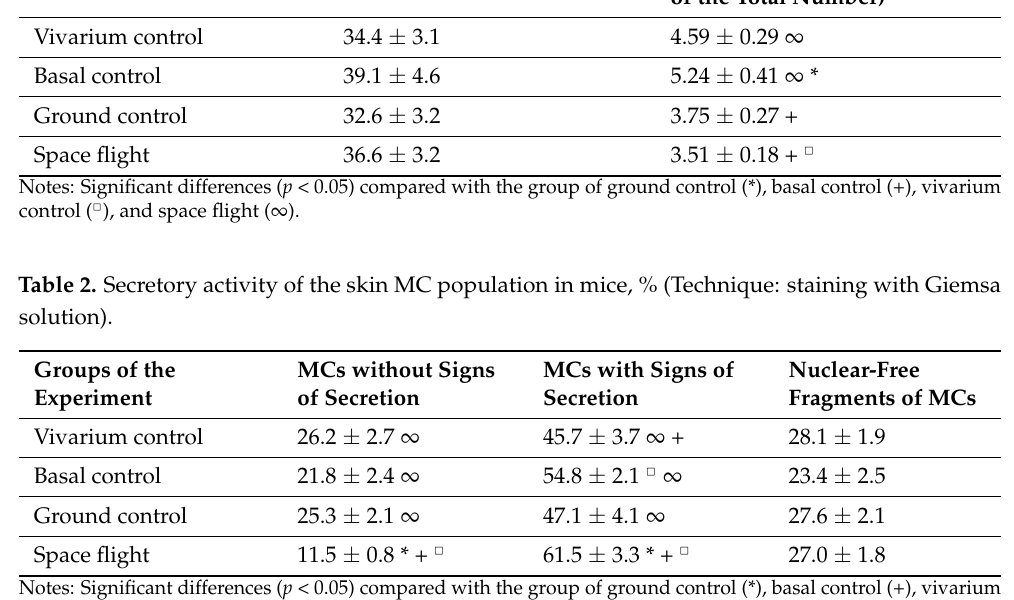
( a ) Fibroblast-associated mast cells form a multicellular fibrillogenic cluster. Active excretion of mast cell secretome into the extracellular matrix. ( b – e ) Co-localization of mast cells and secretory granules with fibroblasts (indicated by an arrow). ( f , g ) Location of secretory granules in the extracellular matrix of the connective tissue of the skin dermis, including large-sized granules (indicated by an arrow). ( h ) Loss of secretome metachromacy in the central region of a large mast cell granule during secretion (indicated by an arrow). ( i , k ) Increased secretory activity of contacting mast cells. ( j ) Large area of mast cell cytoplasm, diffuse distribution of granules in the reticular dermis. ( l , m ) Active secretion of mast cells in the reticular dermis with distribution of granules in the specific tissue microenvironment of the skin. ( n ) Formation of mast cells with outgrowths of the cytoplasm (indicated by an arrow). Scale bar: 5 µ m. Table 1. Features of the skin MC population in mice (Technique: staining with Giemsa solution). The Frequency of MCs’ Adherence to Each Other (in % Groups of the Experiment Number of MCs (per 1 mm 2 ) of the Total Number) Vivarium control 34.4 ± 3.1 4.59 ± 0.29 ∞ Basal control 39.1 ± 4.6 Ground control